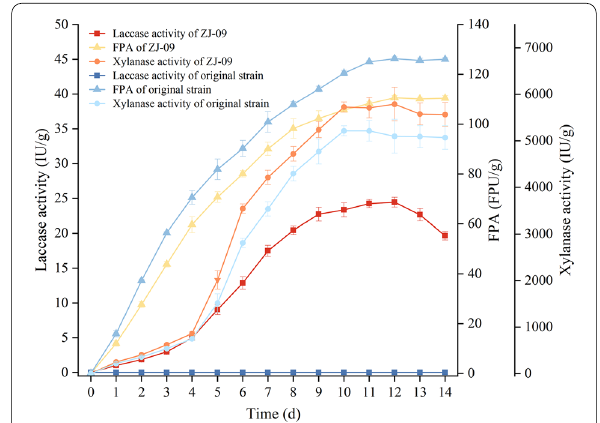
Fig. 3 Cellulase, xylanase, and laccase production by recombinant T. reesei ZJ-09 and original strain under optimized SSF conditions using rice straw as substrate. Error bars represent the standard deviation of three independent